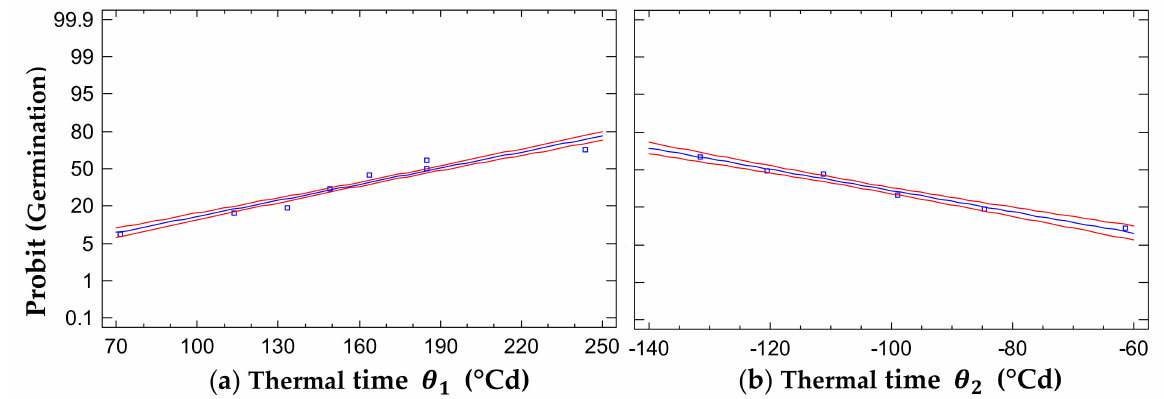
Figure 4. Germination in a Probit scale as a function of thermal time for: ( a ) sub-optimal range, θ 1 , ( b ) supra-optimal range, θ 2 , of temperatures. The red lines are confidence intervals of germination. The blue line is the estimated data. The points are the average of the experimental data.